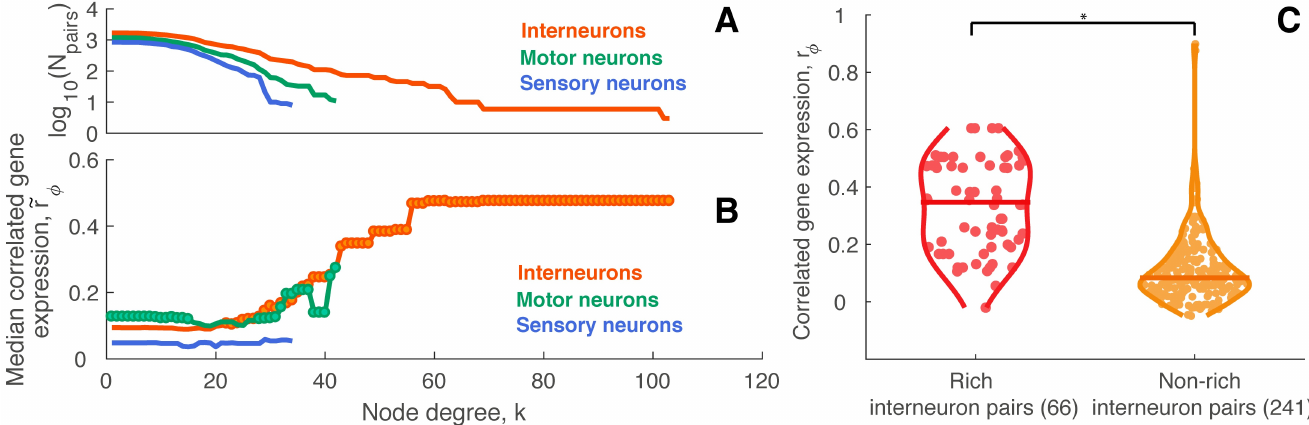
Fig 7. Correlated gene expression is highest for hub interneurons. (A) The number of connected neuron pairs involving interneurons (orange), sensory neurons (blue), and motor neurons (green) across degree threshold, k , represented as log 10 (number of links). (B) Median CGE as a function of degree for connections involving different types of neurons. Circles indicate a statistically significant increase in CGE in a given link type relative to the rest of the network (one-sided Wilcoxon rank-sum test, p < 0.05). (C) CGE distributions for connected pairs of hub interneurons (red) and connected pairs of non-hub interneurons (dark yellow) (Wilcoxon rank sum test, p = 5 × 10 − 21 ). (cid:3) represents statistically significant difference.